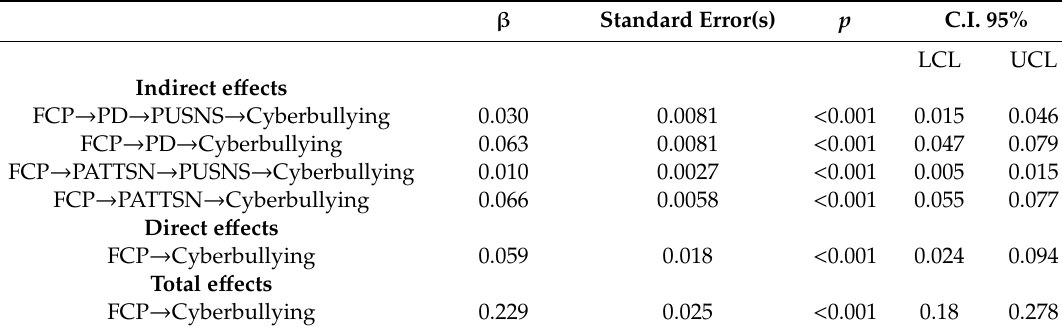
Table 3. Indirect e ff ect, direct, and total e ff ects of the total Table 3. Indirect effect, direct, and total effects of the total model.